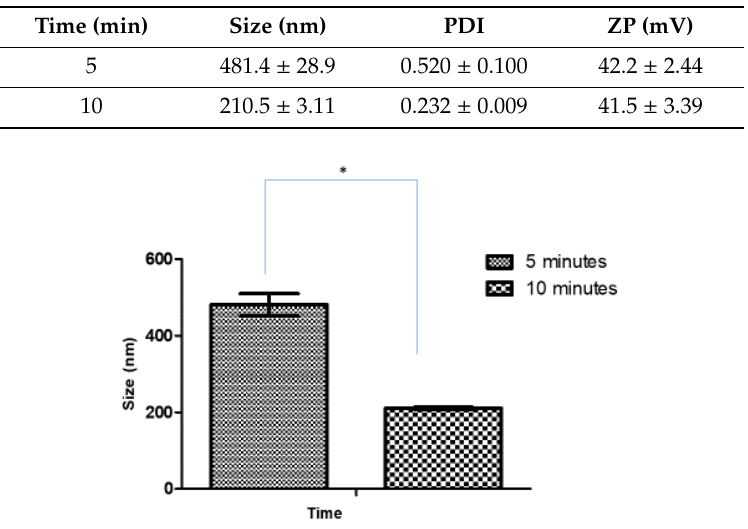
Figure 2. Effect of sonication time on the size of Ag-FSE CSNPs (5mg); *significant difference with CSNP sizes (p < 0.05).